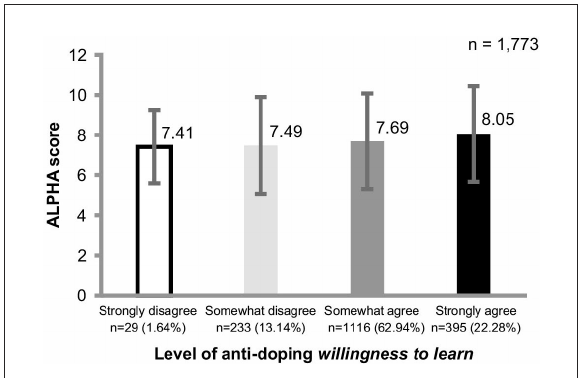
FIGURE1 Comparison of anti-doping willingness to learn level and ALPHA scores. n (%) is the percentage of the total number of athletes. The Willingness to learn score was obtained using the anti-doping willingness to learn question, “Would you like to learn more about anti-doping?” and the selected option based on a 4-point Likert scale ranging from 1: strongly disagree to 4: strongly agree (score range: 1–4). ALPHA score: Score range 0–12 points. ALPHA passing index is ≥ 10 points/correct answer rate ≥ 80%. The ALPHA correct answer rates showed significant differences in the main effect by the level of willingness to learn ( p < 0.05, η 2 = 0.01), although the effect size was small and multiple comparisons showed no significant differences between the